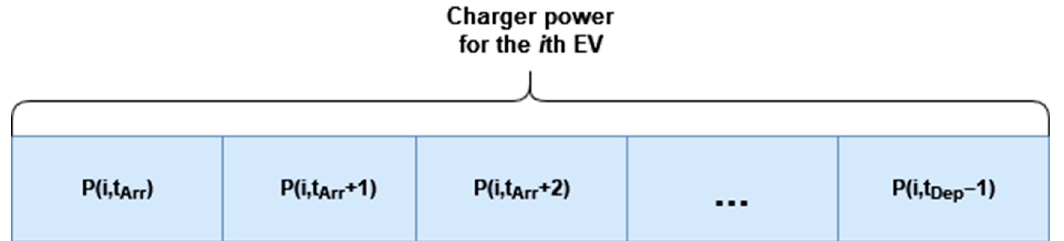
Figure 5. Particle